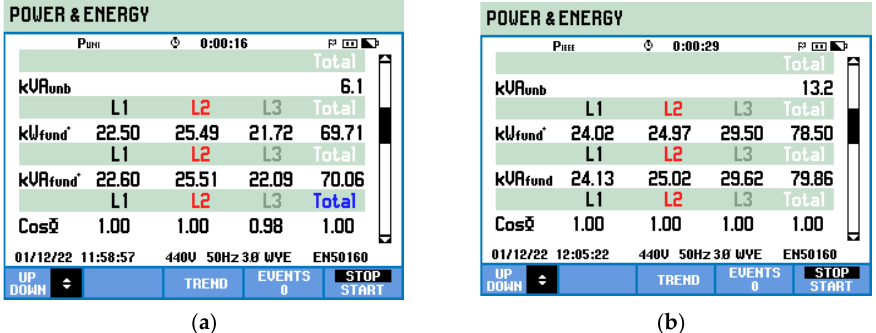
Figure 13. Fluke’s power screens for the PCC of the residential distribution network according to: ( a ) Fluke’s unified power measurement (P UNI ) and ( b ) IEEE 1459 (P IEEE ) standard. The screens of the Fluke 435 Series II analyzer do not provide the values of all the powers it measures. This fact can be seen, for example, in Fluke’s power screen, according to UNI (Figure 13a), in which only the values of unbalanced power (kVAunb), fundamen- tal-frequency positive-sequence active power (kWfund+), and fundamental-frequency positive-sequence apparent power are indicated. Fluke’s power screen, according to IEEE (Figure 13b), only shows the values of the unbalanced power (kVAunb), the fundamental- frequency positive-sequence active power (kWfund+), and the fundamental-frequency apparent power (kVAfund). Therefore, the comparison with the powers calculated by the EPC software (Figure 14) was made based on these powers only (Table 1).